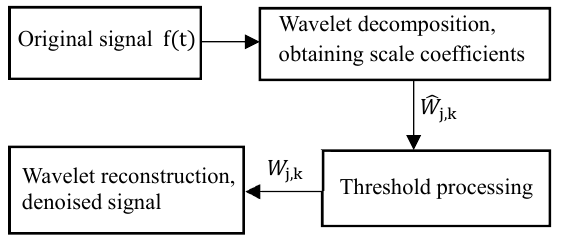
Figure 3. Wavelet threshold method denoising flow